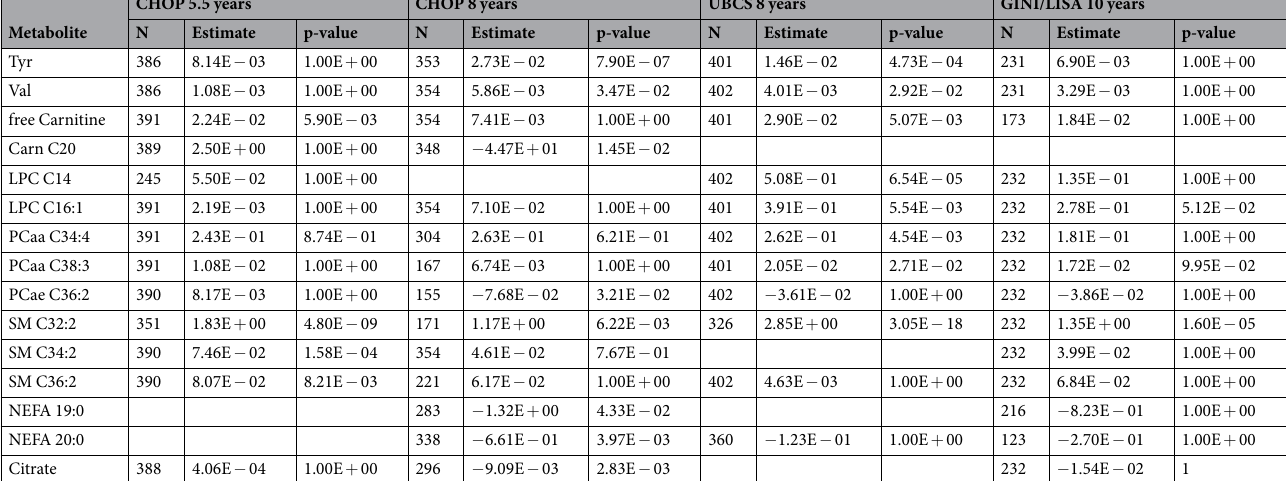
Table 2. Significant associations with BMI z-score in the three studies/four follow-ups. Results are from